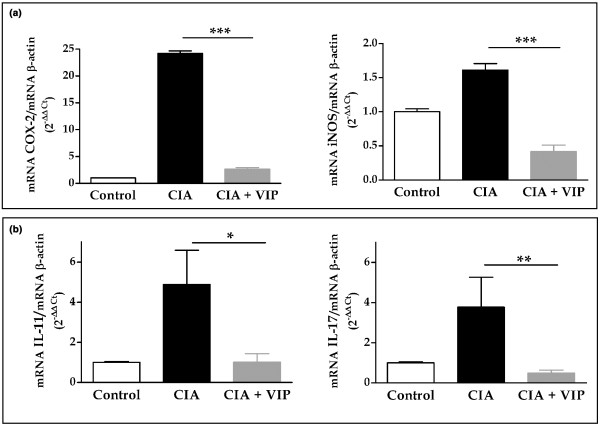
mRNA expression of inflammatory mediators and cytokines related to bone destruction. (a) Expression of mRNA for cyclooxygenase-2 (COX-2) and inducible nitric oxide synthase (iNOS) in the hind paws was measured by quantitative real-time PCR and corrected by mRNA expression for β-actin in each sample (see Materials and methods). (b) Expression of mRNA for IL-11 and IL-17 in the hind paws was measured by quantitative real-time PCR and corrected by mRNA expression for β-actin in each sample (see Materials and methods). On day 10 of vasoactive intestinal peptide (VIP) treatment, differences between the arthritic group and the CIA group treated with VIP were statistically significant (*p < 0.05, **p < 0.01, ***p < 0.001). Results are the mean ± SEM of two separate experiments with 10 animals per group.